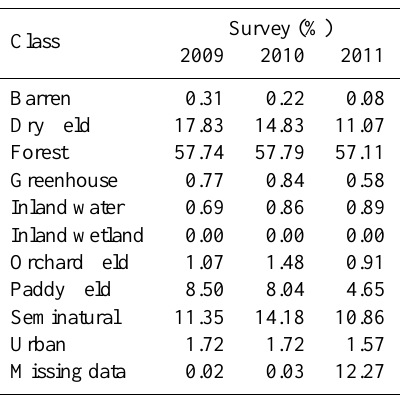
Table 6. Changes in land use and land cover based on the classifi- cation scheme S2. Note that the survey data of 2011 are